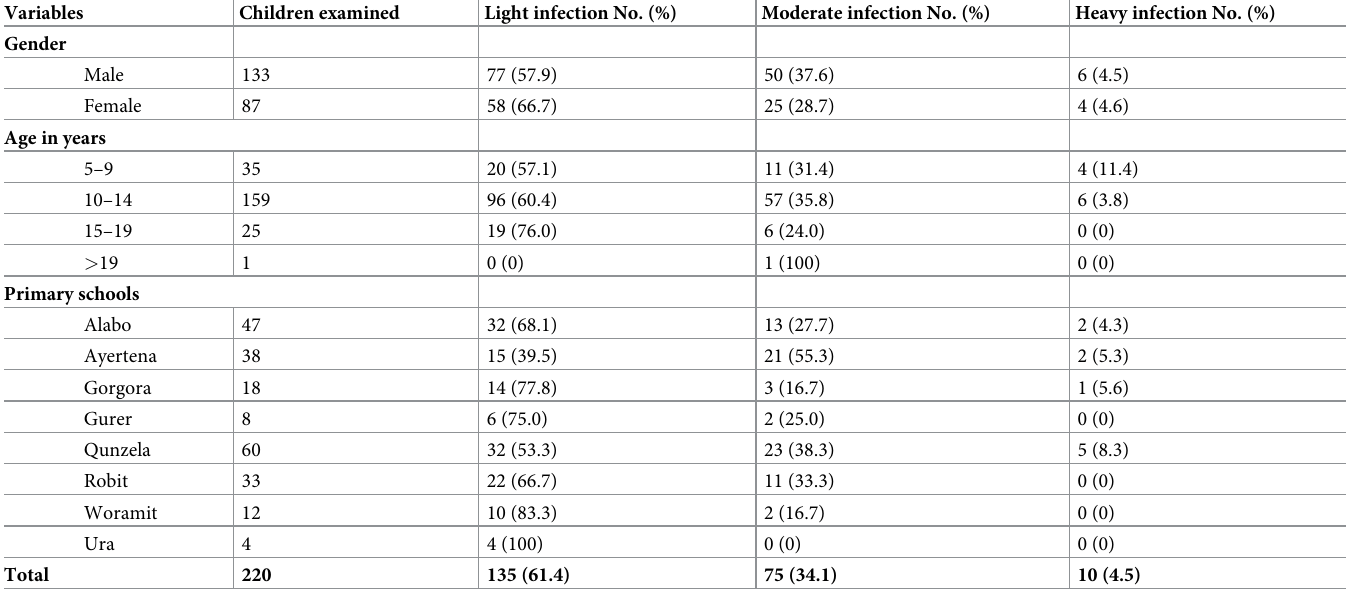
Table 2. Intensity of Schistosoma mansoni infection among schoolchildren using Kato-Katz stool smear technique in selected schools around Lake Tana, northwest, Ethiopia (n = 220), 2021. Variables